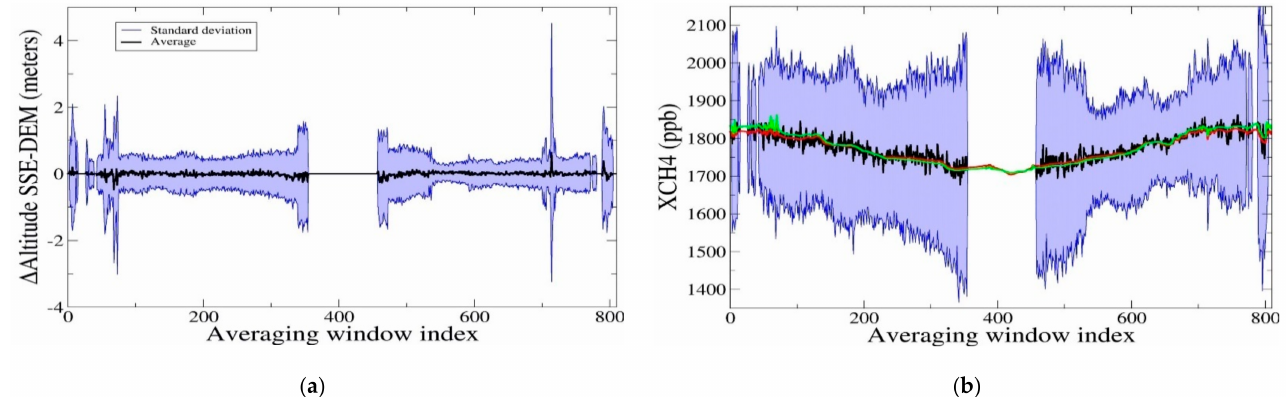
Figure 25. Averaged over 7 s (about 50 km), the black curve gives the average and the blue area shows the one standard deviation variability of the results shot-by-shot. ( a ). Differences between the SSE retrieved by PROLIDL1 and the horizontal average over 140 shots of the DEM. ( b ). XCH 4 retrieved by PROLIDL2, the actual XCH 4 and the reference XCH 4 (green and red curve as in Figure 24) also averaged over 140